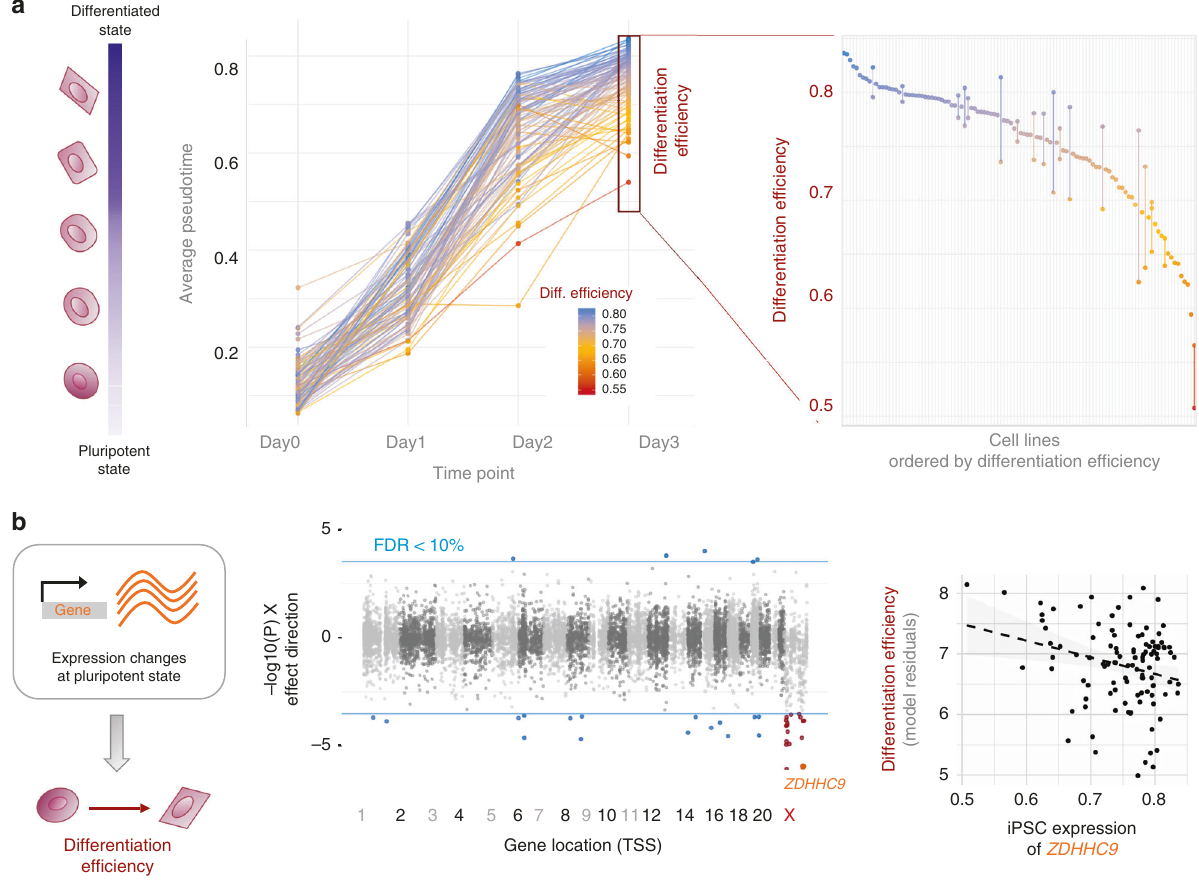
Fig. 5 Identi fi cation of molecular markers for differentiation ef fi ciency. a Variation in differentiation ef fi ciency across cell lines. Left: Differentiation progress over time, showing trajectories for 98 cell lines, coloured by differentiation ef fi ciency. Shown are 98 cell lines with suf fi cient data at all time points (out of 126, more than 10 cells). Differentiation ef fi ciency of a cell line was de fi ned as the average pseudotime across all cells on day 3. Right: Differentiation ef fi ciency across cell lines (points), and consistency of individual cell lines differentiated in multiple experiments (vertical bars). b Associations between iPSC gene expression levels and differentiation ef fi ciency. Left: schematic. Centre: Genome-wide analysis to identify markers of differentiation ef fi ciency, considering iPSC gene expression levels. Displayed are negative log P -values signed by the direction of the effect. Horizontal blue lines denote FDR = 10% (Benjamini-Hochberg adjusted). Autosomal genes with signi fi cant associations are shown in blue; X chromosome genes with signi fi cant associations are shown in red. Right: Scatter plot between gene expression in the iPS state and differentiation ef fi ciency for the X chromosome gene ZDHHC9